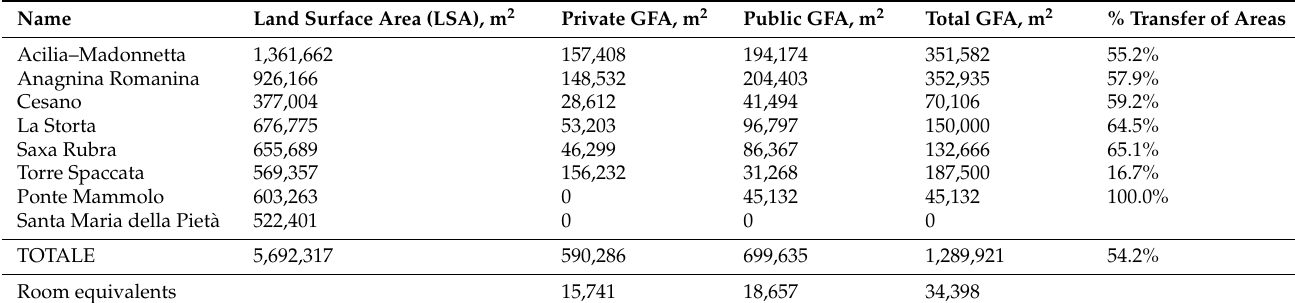
Table 1. Centralities to be planned. Construction